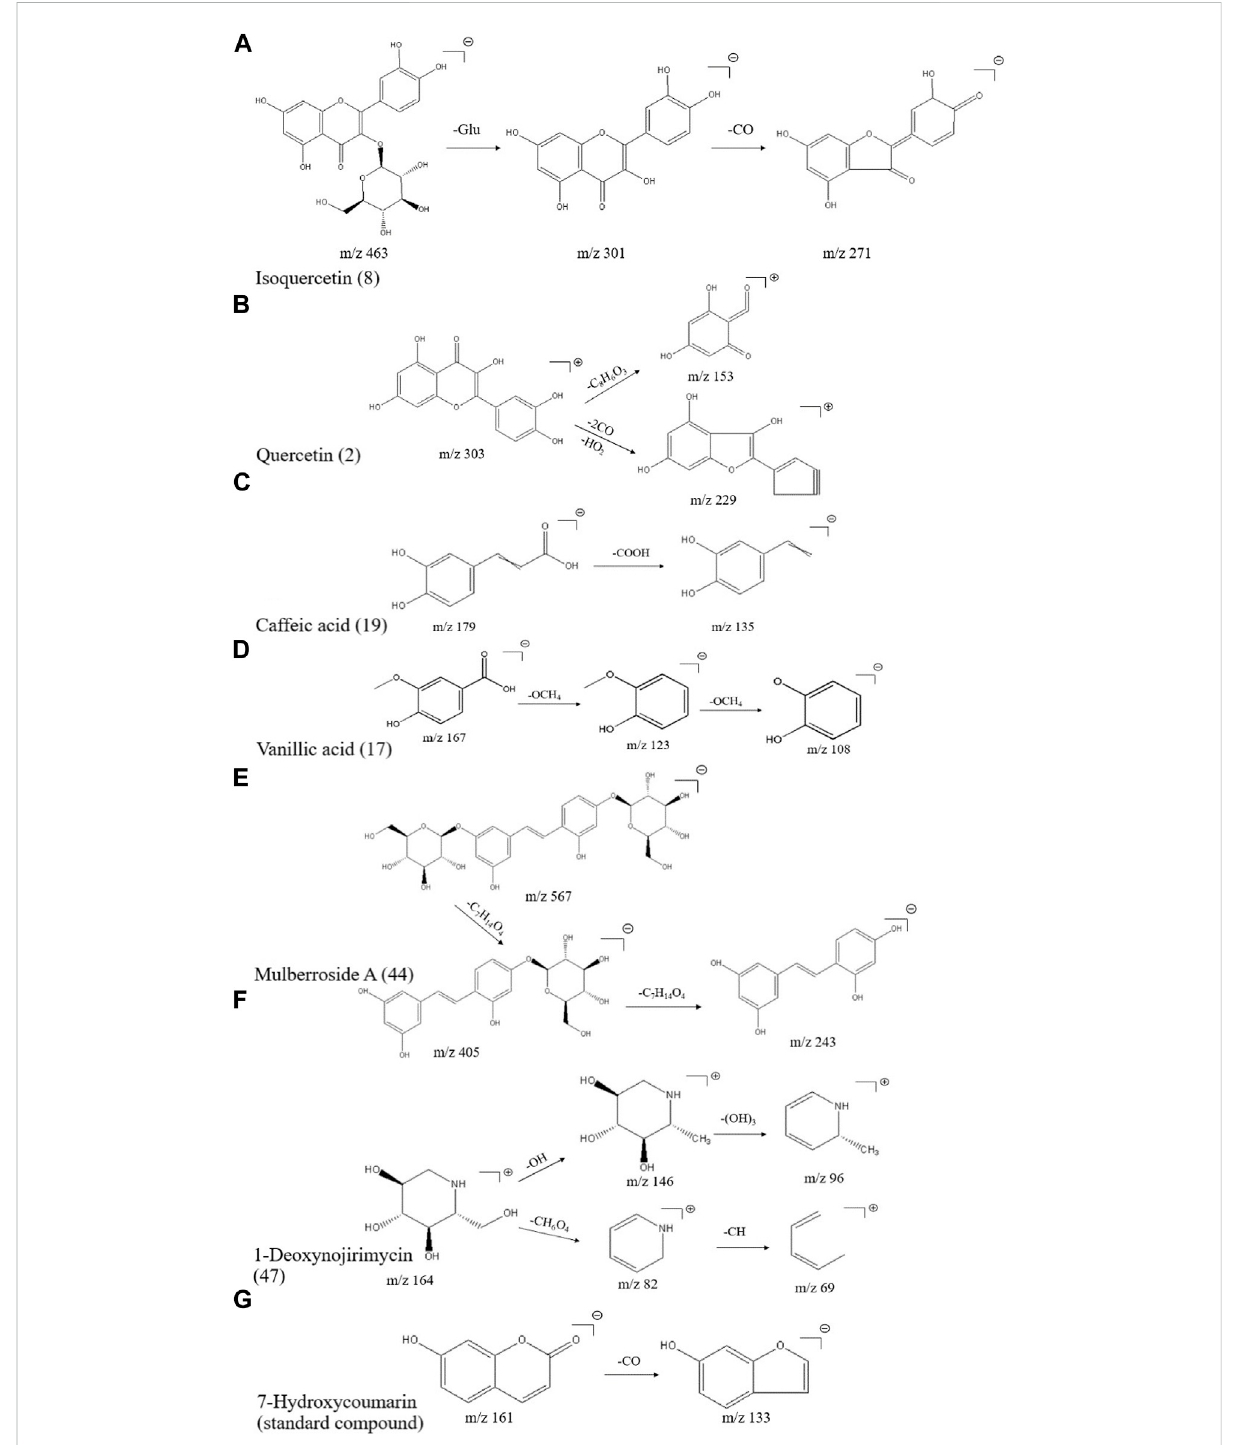
FIGURE 2 Mass spectrometric cleavage patterns of some chemical components of MLs (A) Isoquercitrin (B) quercetin (C) caffeic acid (D) vanillic acid (E) mulberroside A (F) 1-deoxynojirimycin, and (G) 7-hydroxycoumarin.